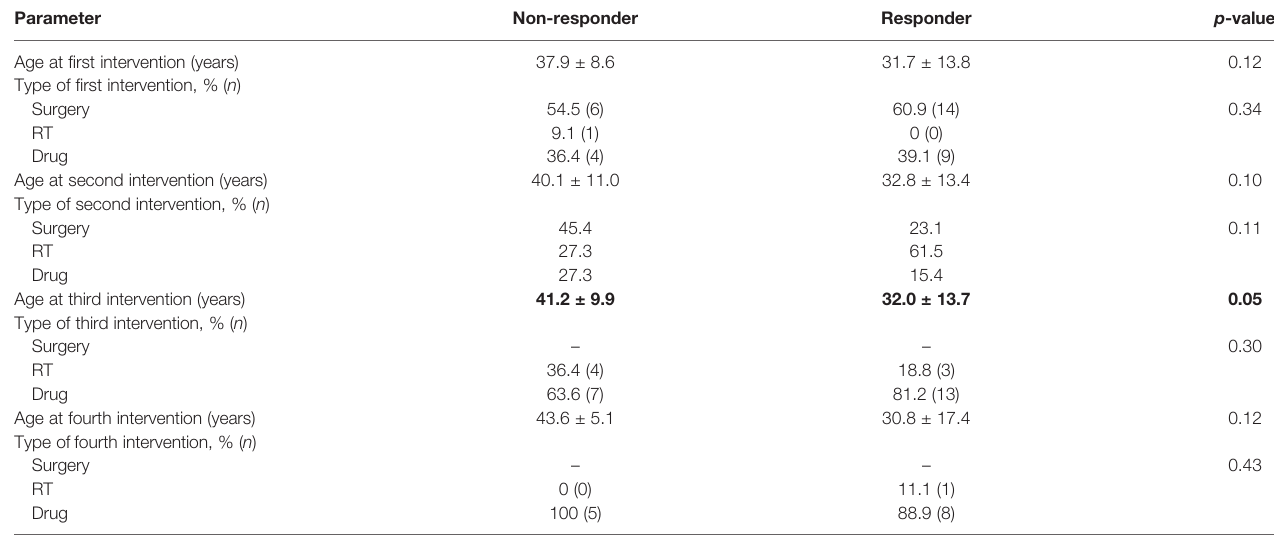
Parameter Age at fi rst intervention (years)